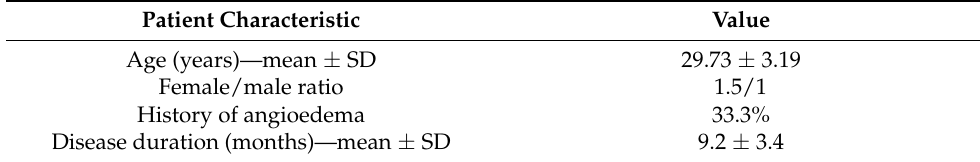
Table 1. The characteristics of the patients with chronic spontaneous